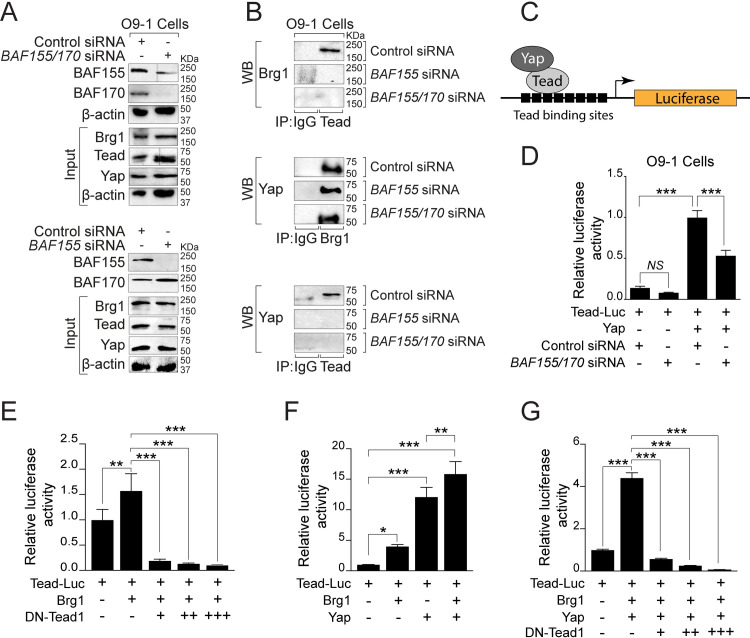
BAF complex is essential for Brg1-Yap-Tead-dependent transcription of target genes in NCCs.(A) Western blot for BAF155 and BAF170 using protein extracts from O9-1 cells transfected with control, BAF155 or BAF155/170 siRNA for 72 hours. Knockdown efficiency was evaluated by BAF155 and BAF170 western blots. Input blots for Brg1, Tead, and Yap together with β-actin controls are presented. (B) Cell extracts from control siRNA, BAF155 siRNA, and BAF155/170 siRNA transfected cells were prepared for immunoprecipitation (IP) using IgG control and anti-pan Tead antibody followed by western blotting (WB) for Brg1. IP was performed using IgG control and anti-Brg1 antibody followed by WB for Yap. Similarly, IP was performed using IgG control and anti-pan Tead antibody followed by WB for Yap. Representative blots are presented. (C) Schematic illustration of the Tead luciferase reporter construct with Tead and Yap. (D) Results of normalized luciferase reporter assays in O9-1 cells with Tead-luciferase reporter (Tead-Luc) in the presence of control siRNA or BAF155/170 siRNA. (E) Results of normalized luciferase reporter assays in HEK293T cells with Tead-Luc reporter in the presence of Brg1 alone or in combination with dominant-negative Tead1 (DN-Tead1). (F) Results of normalized luciferase reporter assays in HEK293T cells with Tead-Luc reporter in the presence of Brg1, Yap alone, or both. (G) Results of normalized luciferase reporter assays in HEK293T cells with Tead-Luc reporter in the presence of Brg1 and Yap in combination with different doses of DN-Tead1. Values are reported as means ± SD (*P < 0.05, **P < 0.01, ***P < 0.001; NS, not significant).